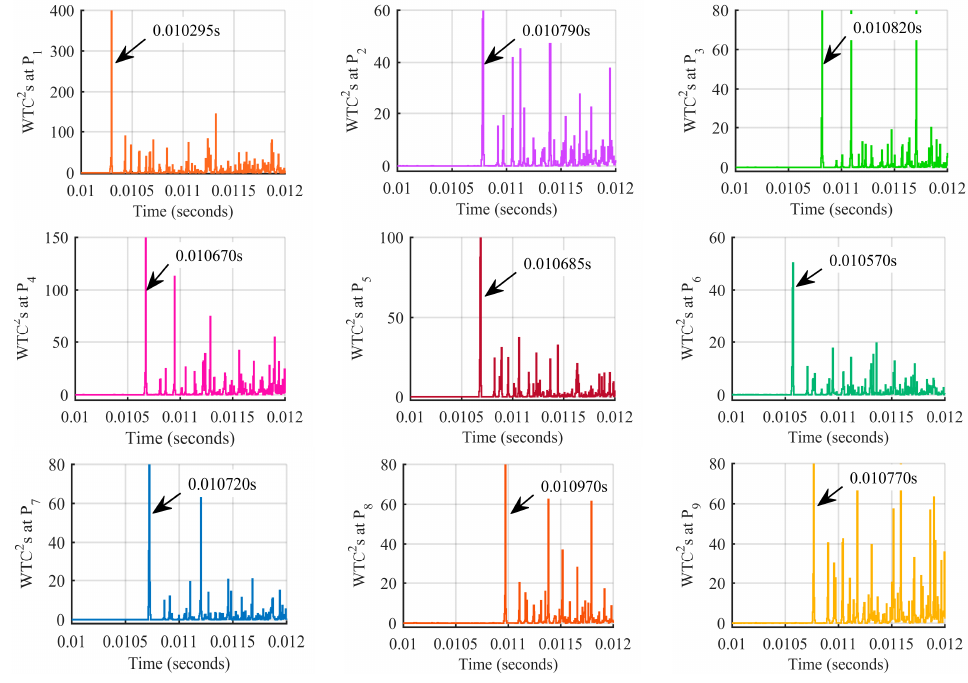
Figure 9. Arrival times at each terminal obtained by voltage WTC 2 s for AG fault F1. Table 3. Arrival times of the initial traveling wave for fault F1 with fault initialization time = 0.01 s.